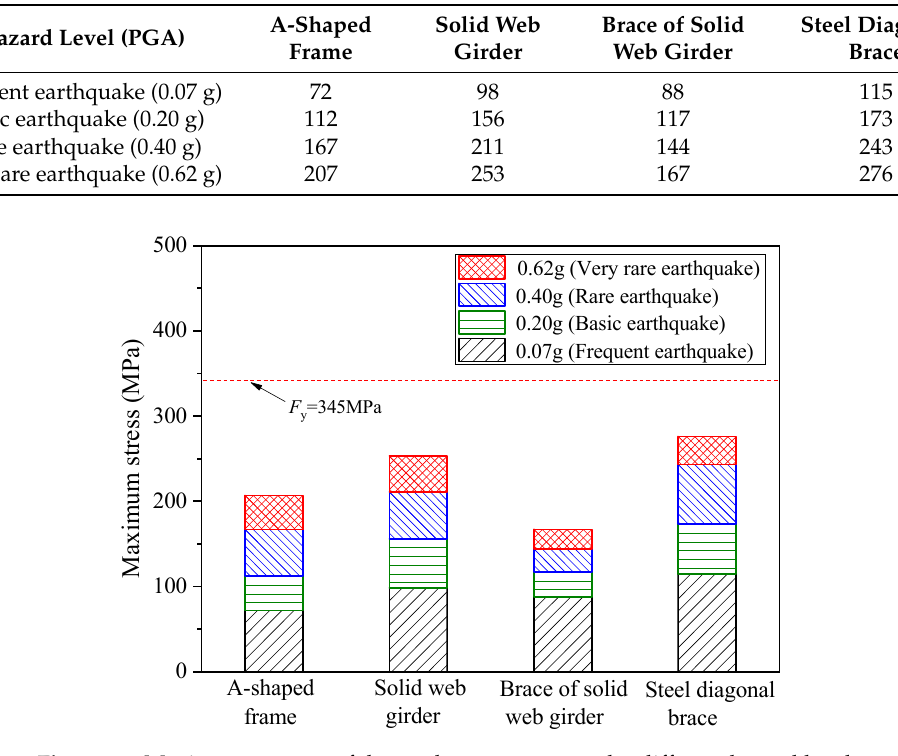
Figure 11. Maximum stresses of the steel components under different hazard levels.